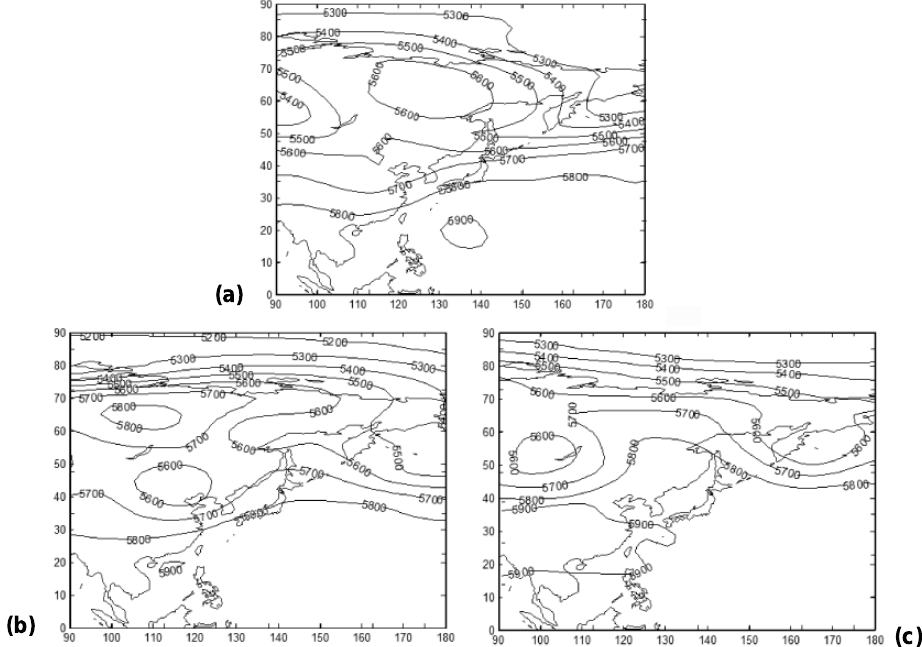
Fig. 10. The summer SH potential fields in 2006 reconstructed (a) before combination with b 4 = − 4, and (b) after combination of the high equilibrium and (c) the low equilibrium with b 4 =